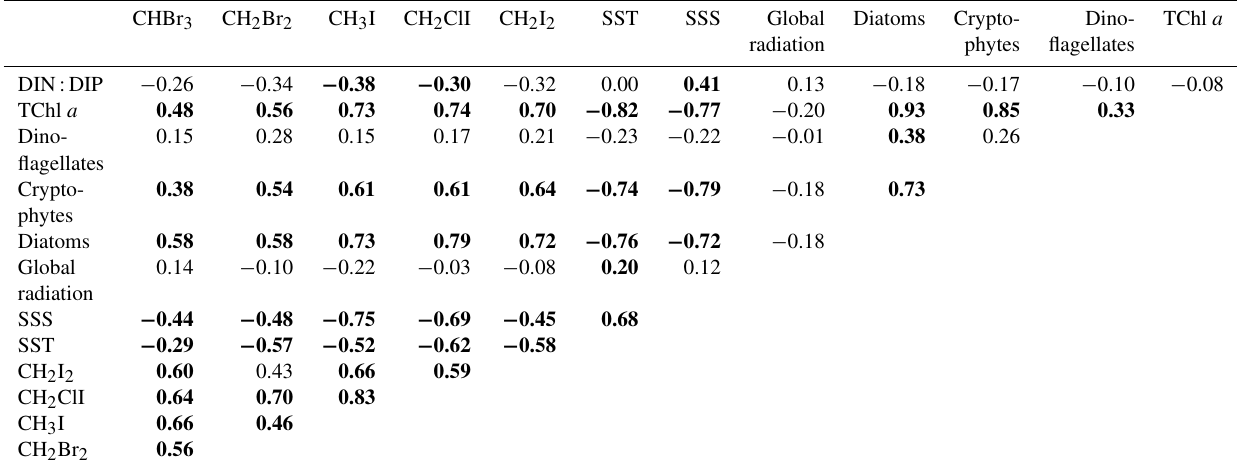
Table 2. Spearman’s rank correlation coefficients of correlations of all halocarbon surface data with several ambient parameters, as well as biological proxies. Bold numbers indicate correlations that are significant at p <0.05 with a sample number of 107 for all environmental data and 46 for all phytoplankton and nutrient data considering all collocated surface